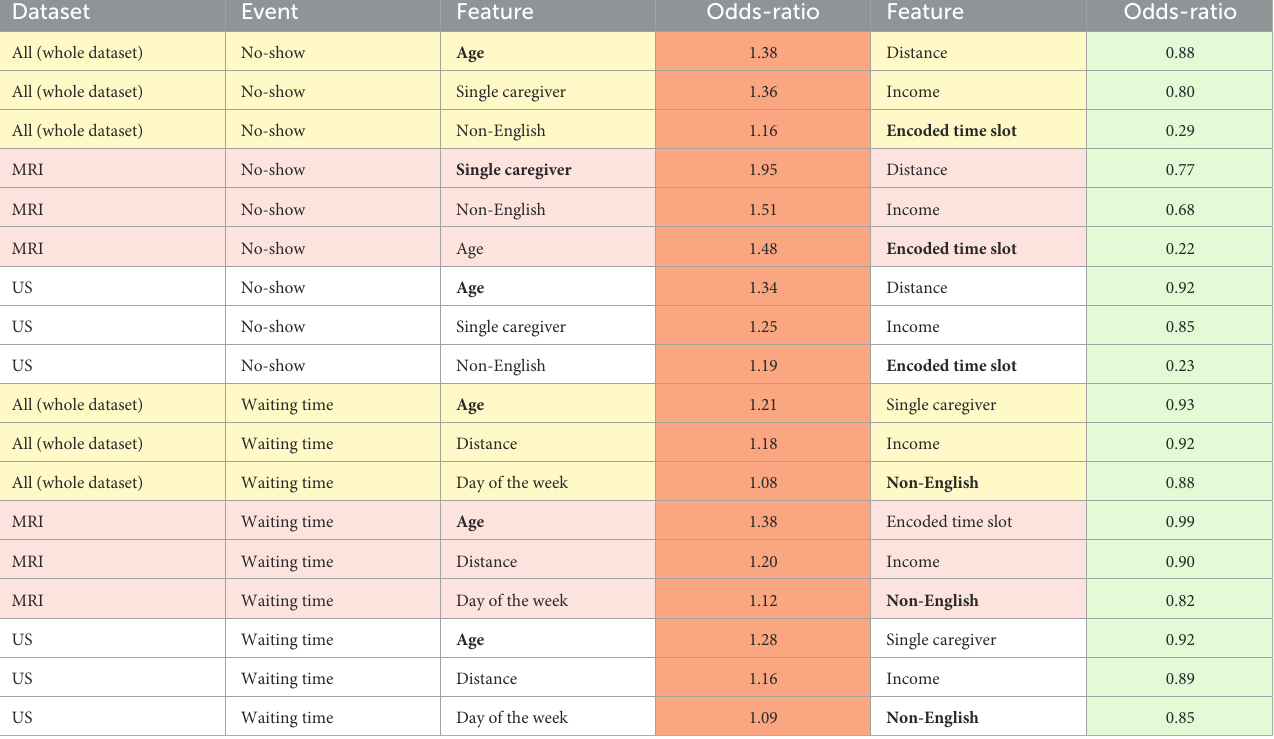
TABLE 3 Odds ratios of the most significant features.